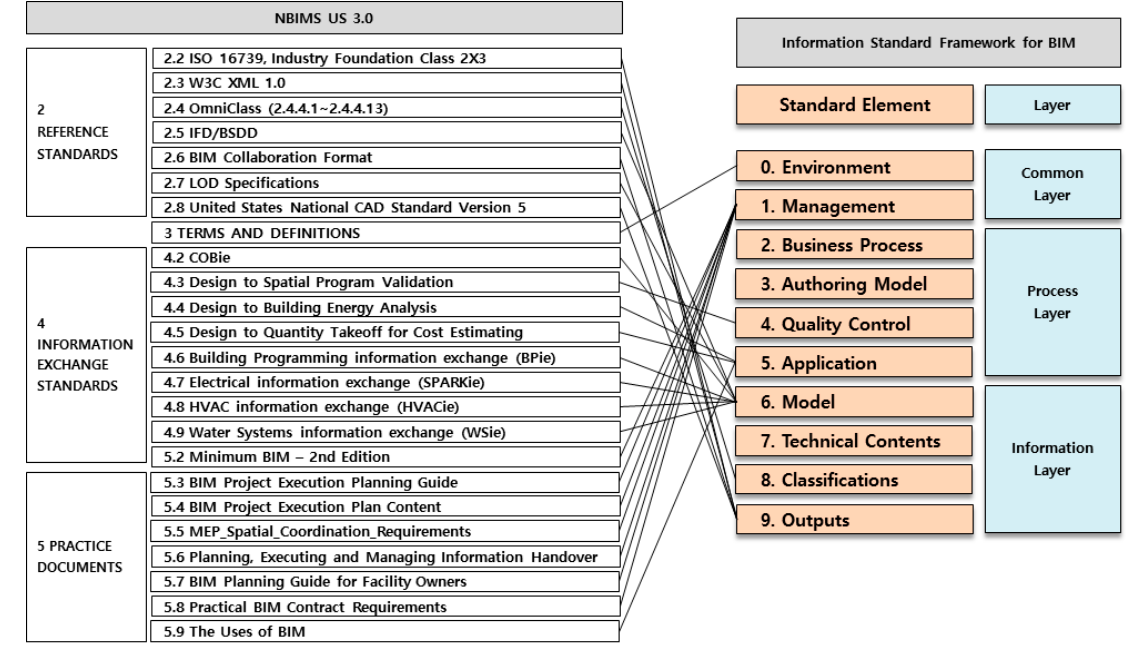
Figure 4. Conformance with NBIMS US 3.0.